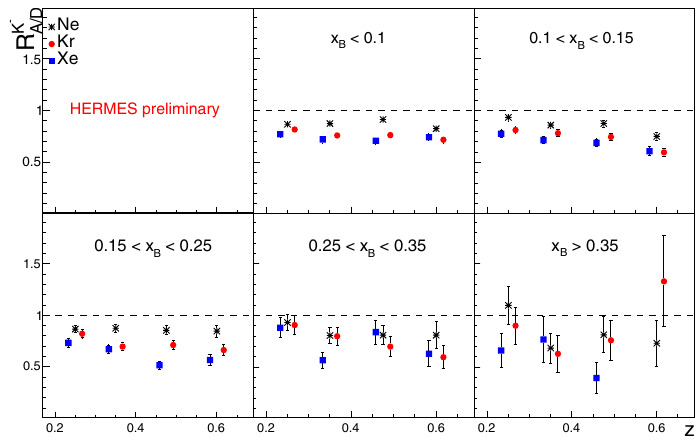
Figure 3. The same as in Fig. 2 for negatively charged kaons